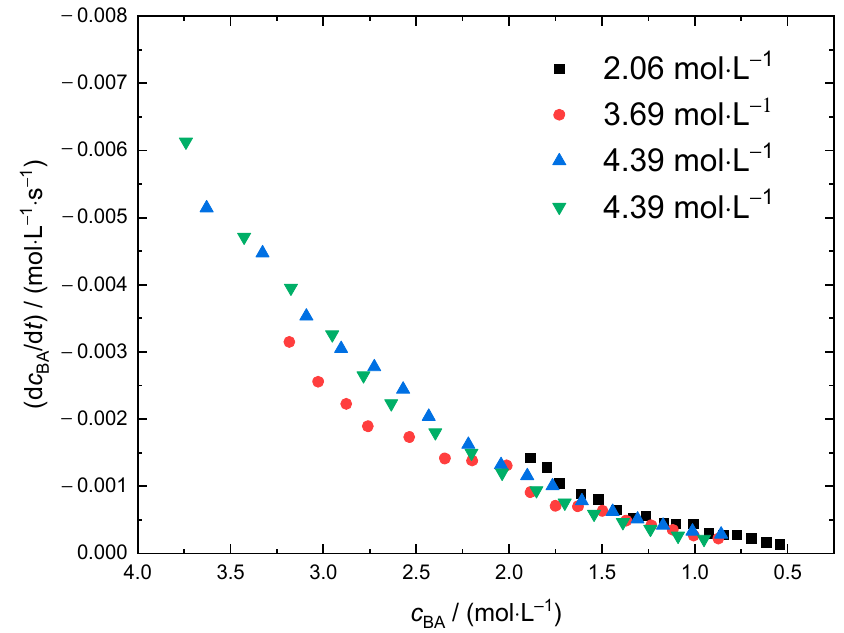
Figure 6. d c BA /d t as a function of the current monomer concentration derived from NIR spectra recording during polymerizations at 120 °C. The legend gives the initial BA concentrations, c BA,0 .